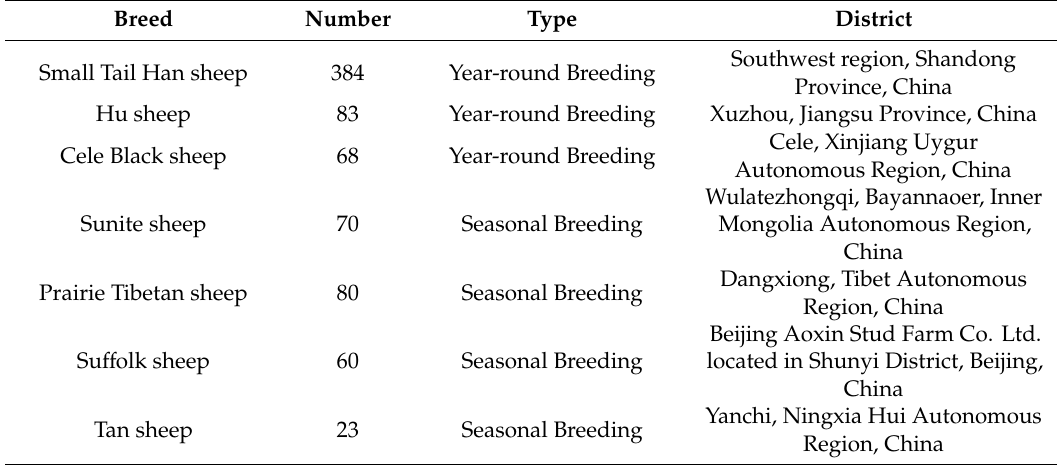
Table 1. Basic information on ewes used in this